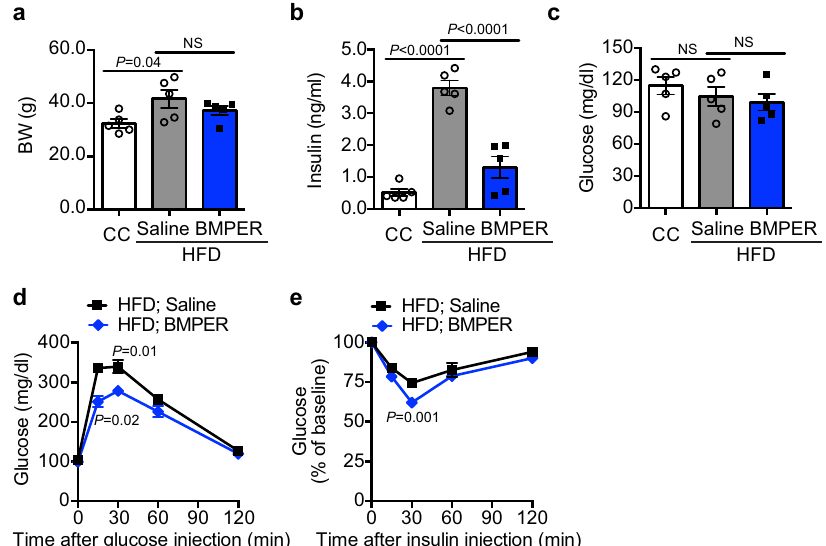
Fig. 7 Recombinant BMPER protein improves glucose responses in DIO mice. C57BL/6 mice were fed HFD or control chow (CC) for 4 weeks and then injected with recombinant BMPER protein at 0.1 mg/kg/mouse every other day for 6 weeks. Metabolic parameters were measured, including a Body weight. b Fasted insulin. c Fasted glucose. d Glucose tolerance tests. e Insulin tolerance tests. n = 4 mice ( a CC), 5 mice ( a HFD), and 5 mice ( b – e ). Data are presented as mean values ± SEM. NS not signi fi cant. Analysis was one-way ANOVA (for a – c ) or two-way ANOVA (for d , e ) followed by Fisher ’ s LSD multiple comparison